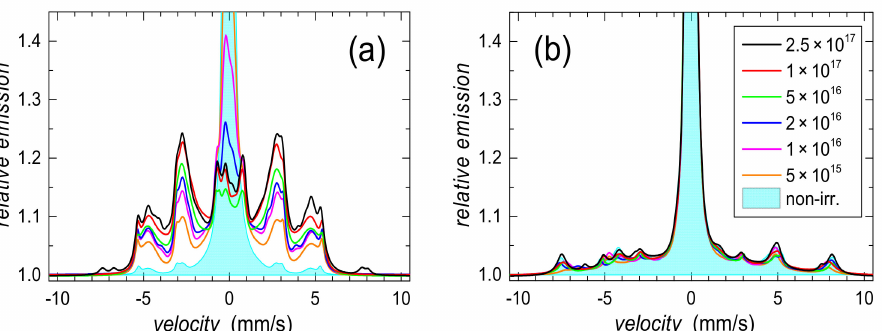
Figure 13. CEMS spectra of 57 Fe 81 Mo 8 Cu 1 B 10 amorphous metallic ribbons recorded from its: ( a ) air side; ( b ) wheel side after irradiation by 130 keV N + ions with the indicated fluences. Principal spectral parameters comprising average values of isomer shift, (cid:104) δ (cid:105) , and hyperfine magnetic field, (cid:104) B (cid:105) , corresponding to CEMS spectra from Figure 13, are plotted in Figure 14 as a function of ion fluence.